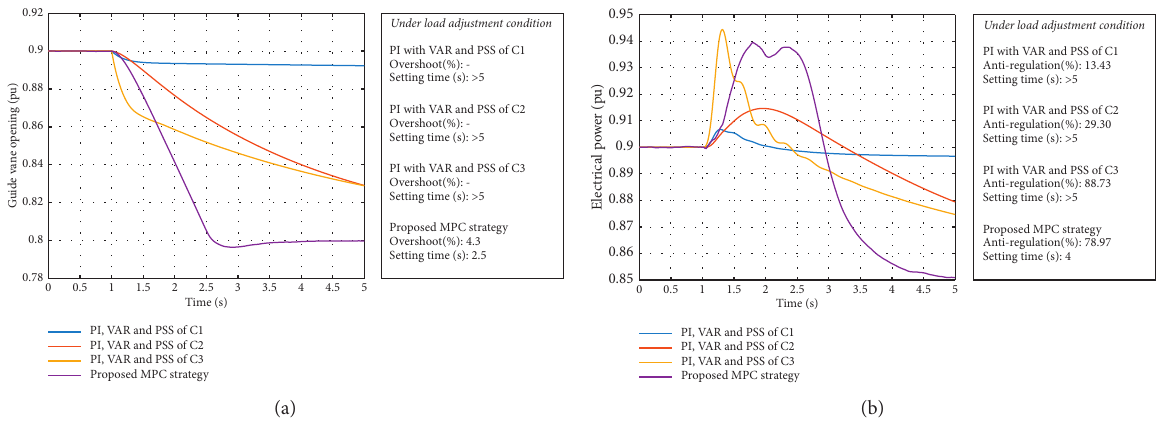
Figure 17: Response comparison under load adjustment condition. (a) Guide vane opening. (b) Electrical power